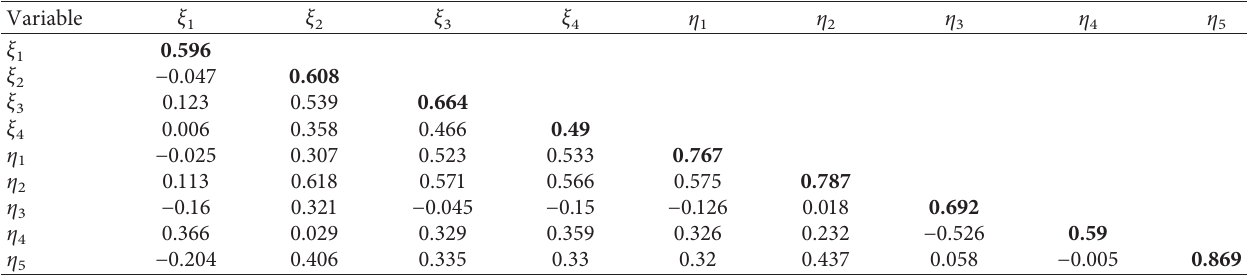
Table 4: Assessment of discriminant validity based on the Fornell–Larcker criteria.